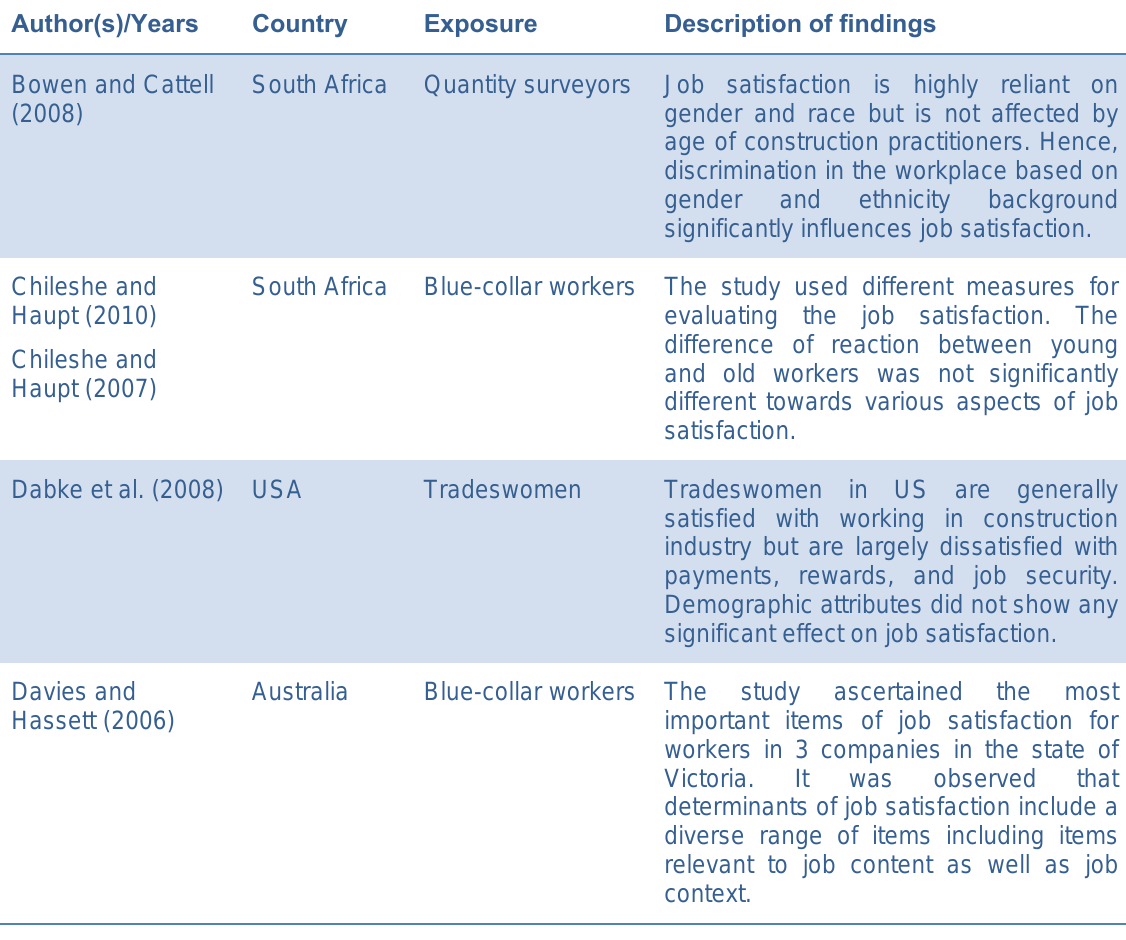
Table 1 : Major studies on job satisfaction in the construction context (alphabetic